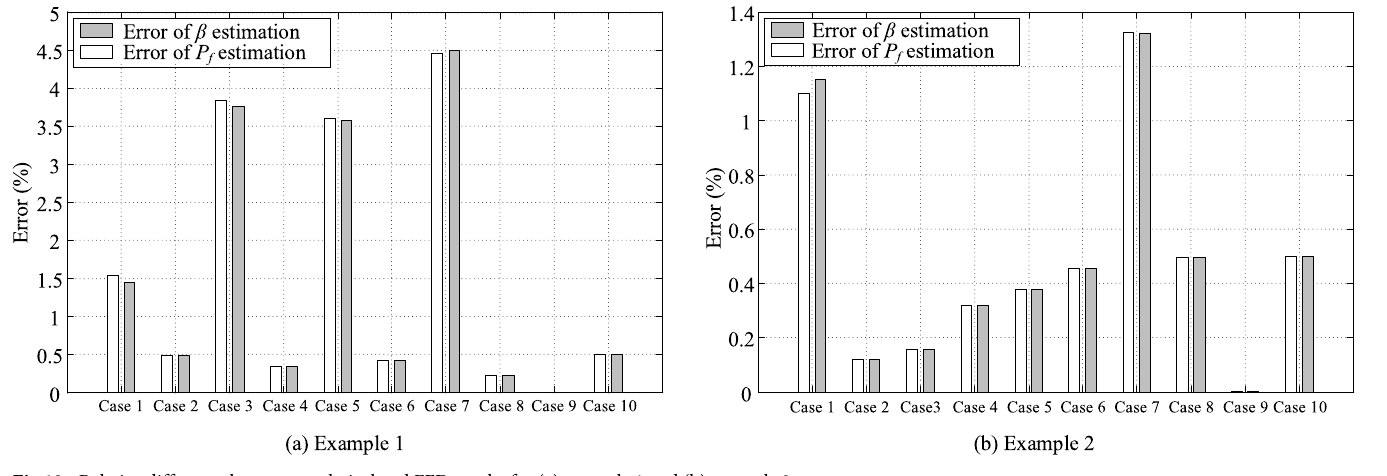
Fig 10. Relative difference between analytical and FFD results for (a) example 1 and (b) example 2.